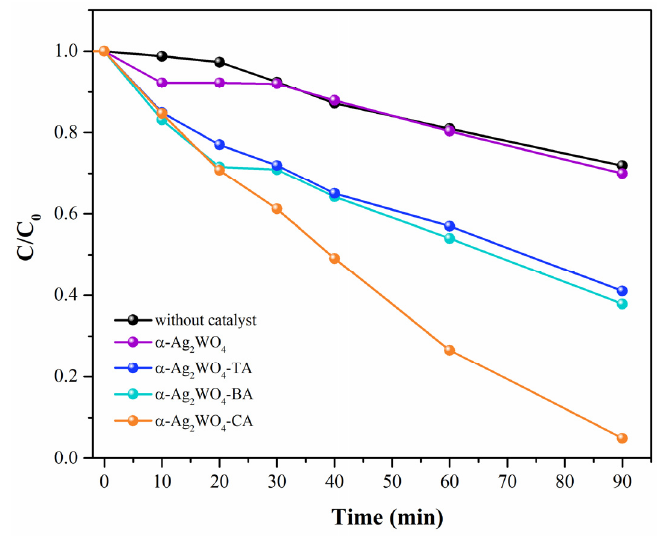
Figure 6. The variation of RhB concentration (C/C 0 ) as a function of irradiation time.